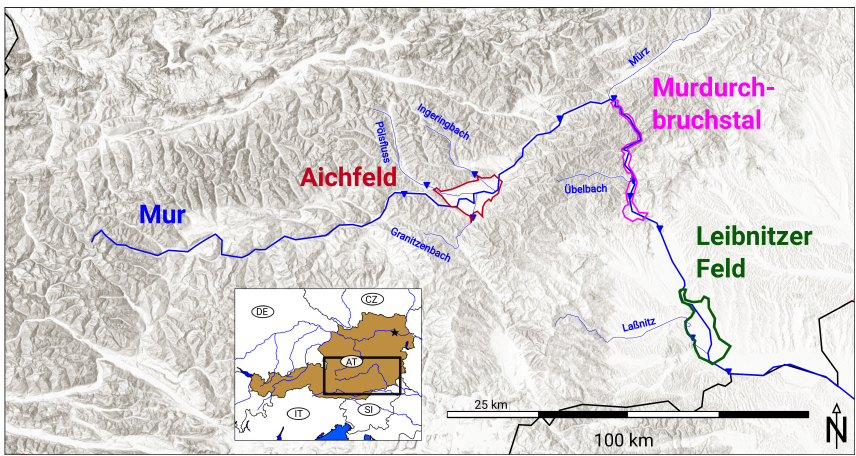
Figure 1. Map of the Austrian Mur catchment and its position within Austria, with the subregions studied in detail. See Appendix B for detailed maps of the